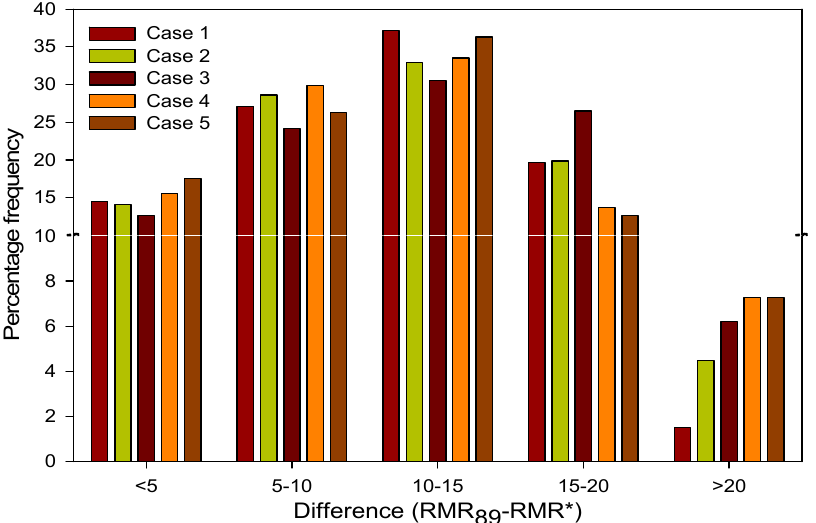
Figure2. Percentagefrequencyofthecalculated RMR 89 andback-calculated RMR di ff erenceconsidering Figure 2. Percentage frequency of the calculated RMR 89 and back-calculated RMR difference the five cases of Table considering the five cases of Table 6.